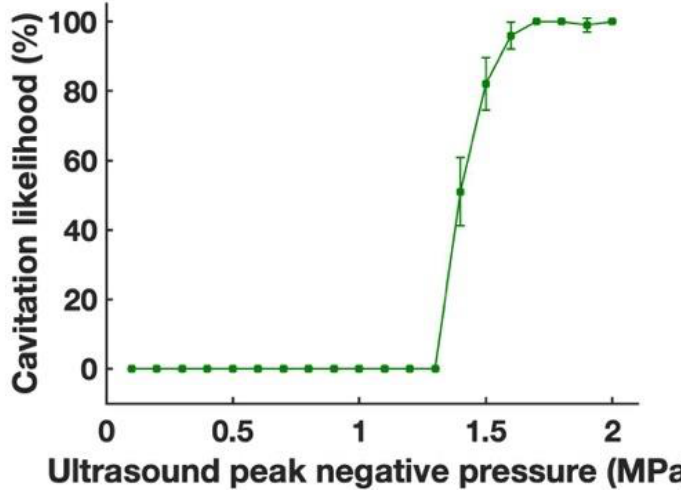
Figure 4. Cavitation likelihood detected using passive cavitation detector.